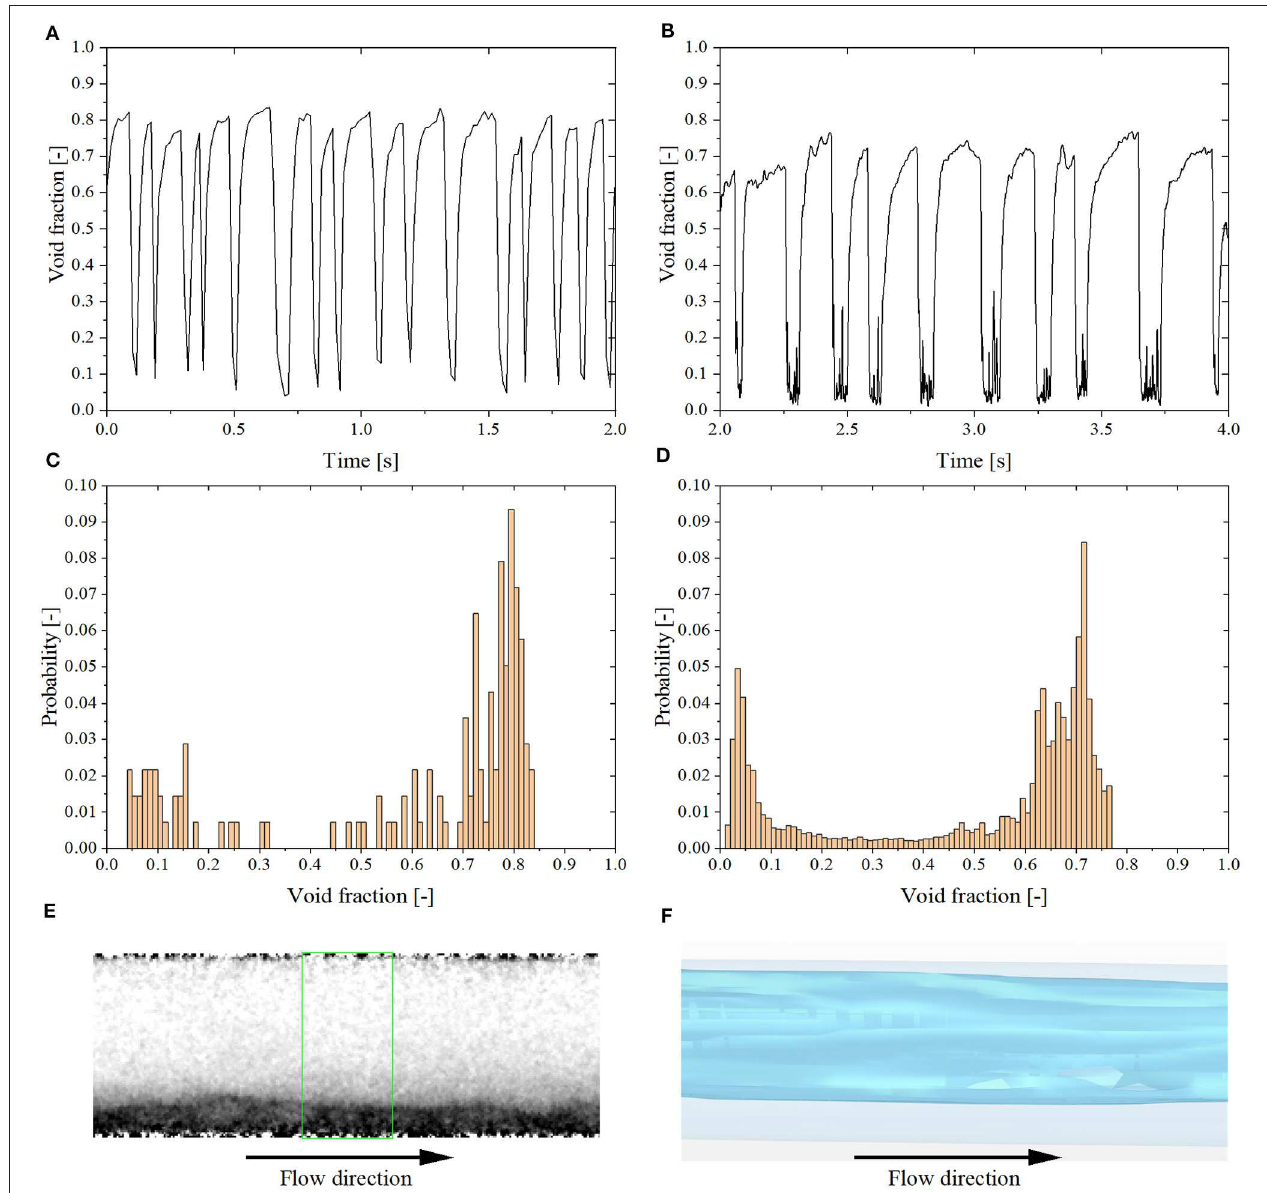
FIGURE 8 | Results of test No. 6. (A) Experimental void fraction time evolution. (B) Simulation void fraction time evolution. (C) Experimental void fraction histogram. (D) Simulation void fraction histogram. (E) X-ray void fraction contrast image. (F) Void fraction isosurface image.